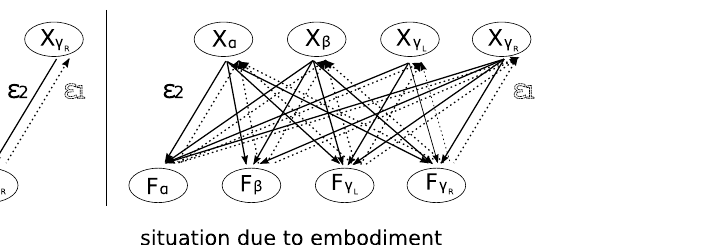
situation is comparable to the schema in the right side where the pair { ε controls the global level of synchronization. In this parameter space, particular values will correspond to characteristic limbs coordinations (i.e., its motor synergies).